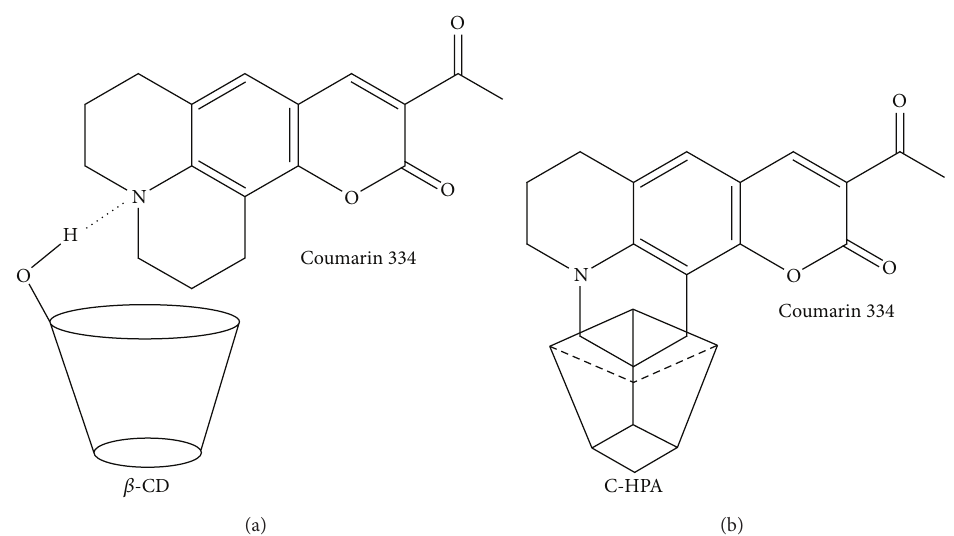
Figure 12: Schematic picture of the interaction of C334 with 𝛽 -CD and with C-HPA.